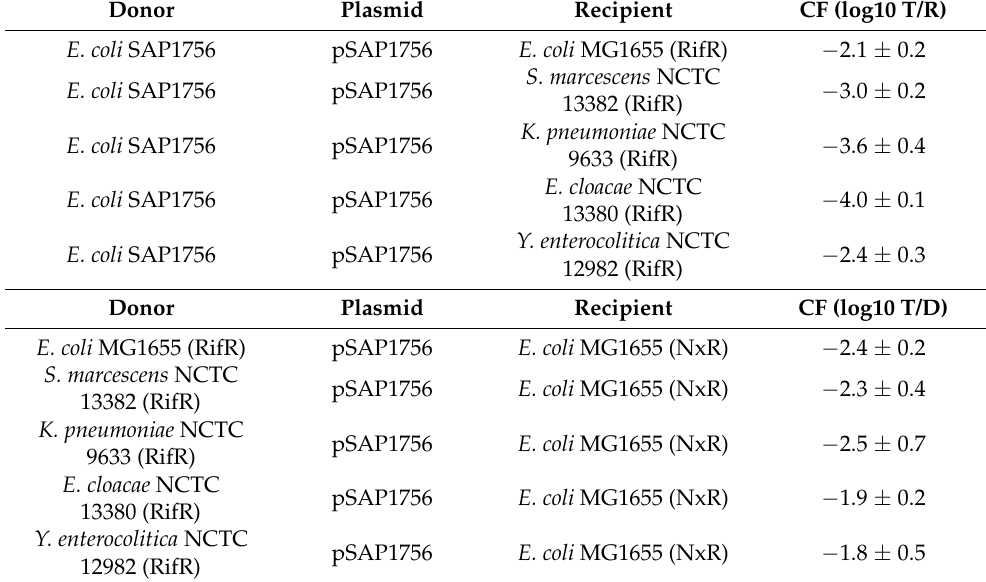
Table 2. Conjugation frequency of IncM2 plasmid pSAP1756 from the original host to different Enterobacterales species and from these different species to E. coli